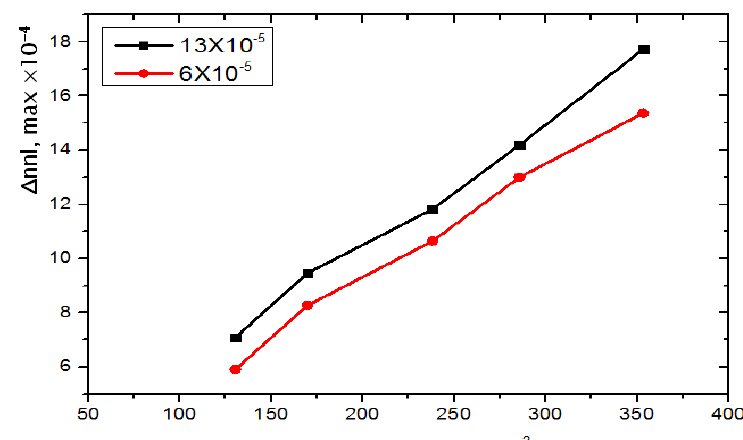
Fig.8: Maximum change of non-linear refractive index created using F- MWCNTs suspension in DI water of the volume fraction (13X10 -5 ), and (6 X10 -5 ) irradiated by laser